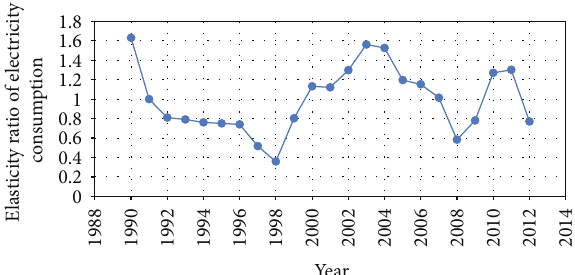
Figure 1: Elasticity ratio of electricity consumption from 1988 to 2012 [21].